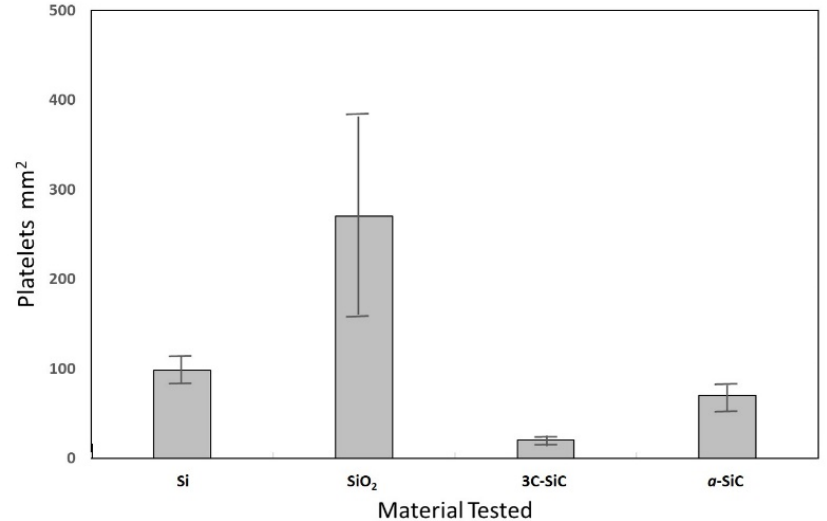
Figure 3. Dynamic hemocompatibility histogram of platelet activation of Si and SiO 2 on Si and 3C- SiC, as well as a -SiC on Si, and using standard deviation as the error bar. Activated platelets per mm 2 were used to evaluate the hemocompatibility of the materials. Test coupons: 50 × 75 mm 2 [3].